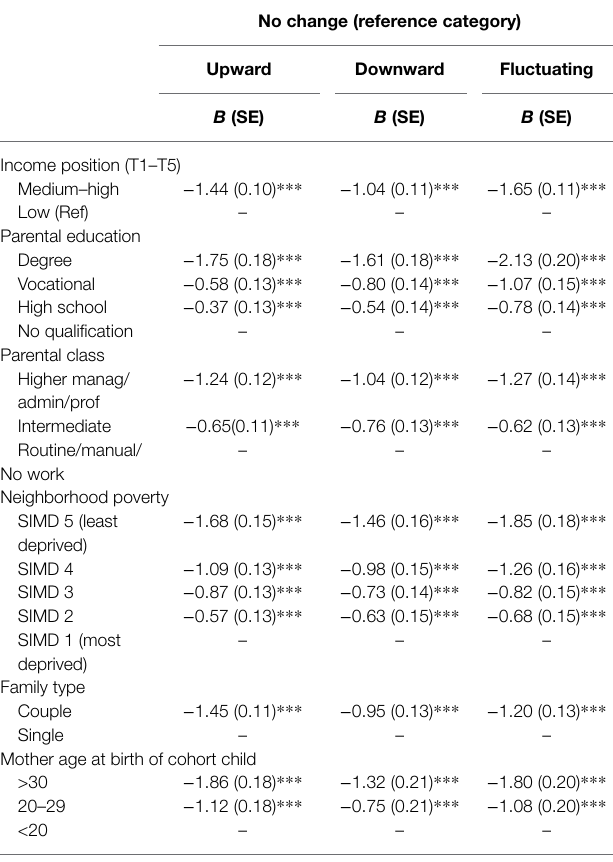
TABLE 3 | Standardized regression coefficients of income dynamics (average income and volatility) and change in cognitive ability from ages 3 to